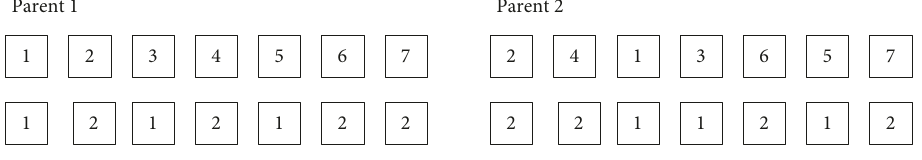
Figure 4: Two parents as an